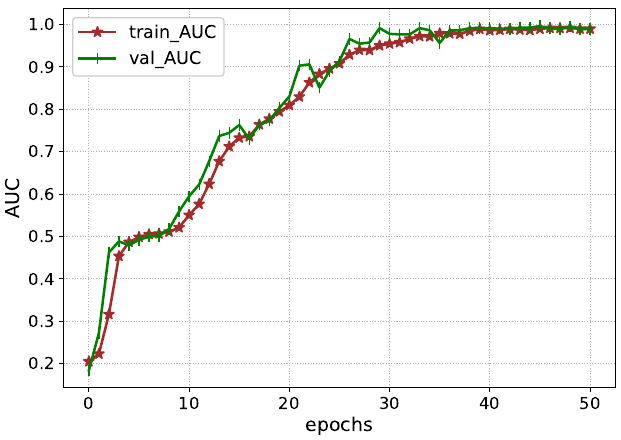
Figure 10. Accuracy of ResNet101-V2 during training.